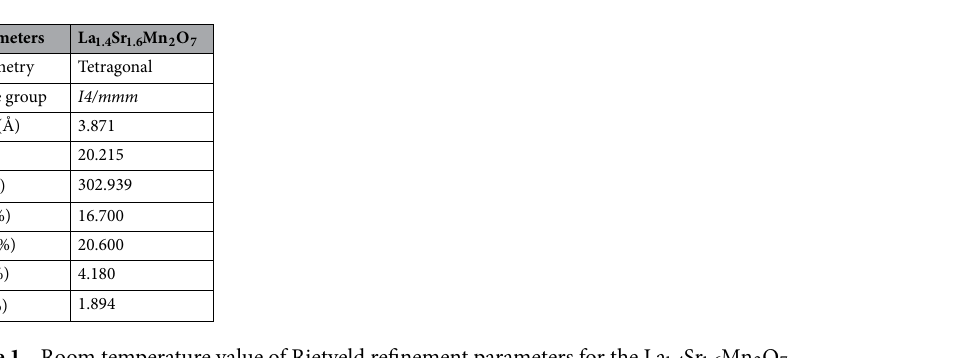
Table 1. Room temperature value of Rietveld refinement parameters for the La 1.4 Sr 1.6 Mn 2 O 7 .